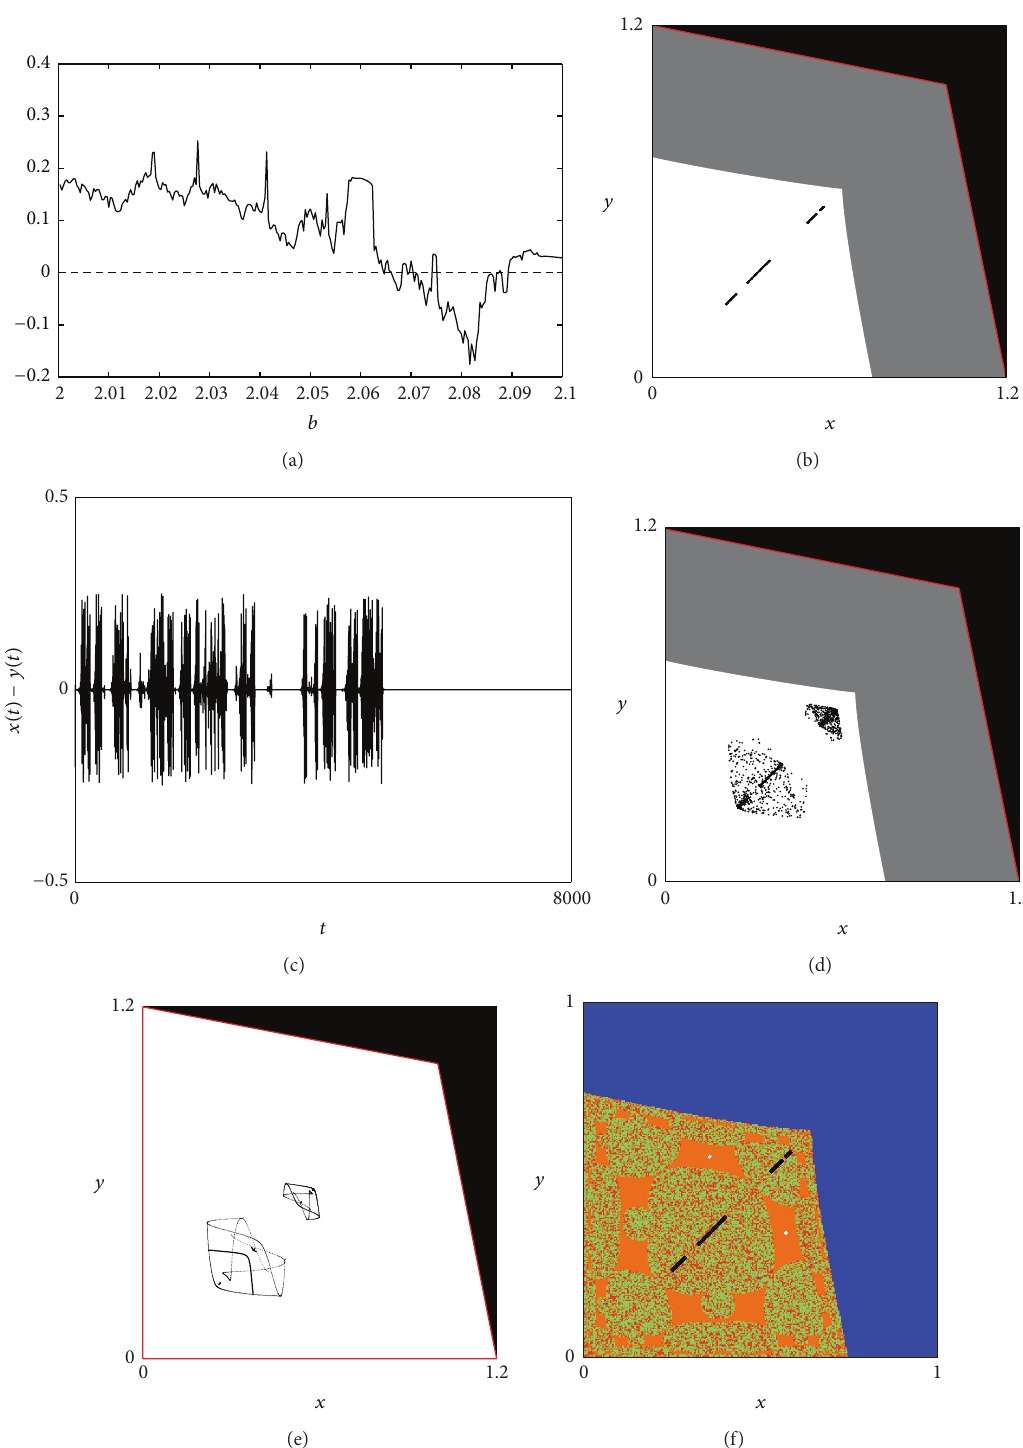
Figure 4: Parameter values: 𝛼 = 1.5 , 𝑑 = −0.2 , and 𝑤 = 0.5 . (a) The natural transverse Lyapunov exponent with respect to parameter 𝑏 . (b) Four-piece chaotic attractor 𝐴 of system 𝑇 𝑏 belonging to the diagonal for 𝑏 = 2.07 . (c) Bursts away from the diagonal before synchronization for 𝑏 = 2.07 , 𝑥(0) = 0.1 , and 𝑦(0) = 0.2 . (d) The whole trajectory starting from initial condition as in (c) and converging to the attractor in (b). (e) The minimal absorbing area in which on-off intermittency phenomenon occurs for the same parameters as in (c). (f) The attractor 𝐴 coexists with an attracting 2-period cycle for 𝑏 = 2.07